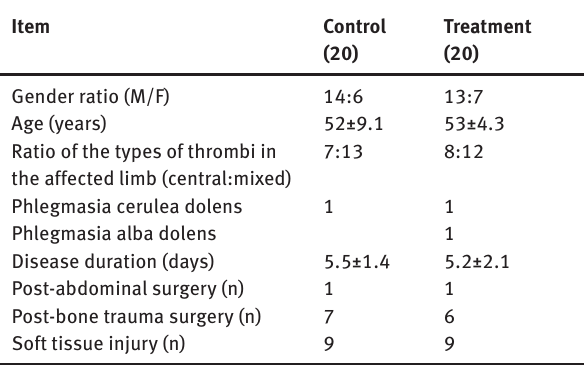
Table 1: Comparison of the baseline data for the patient groups